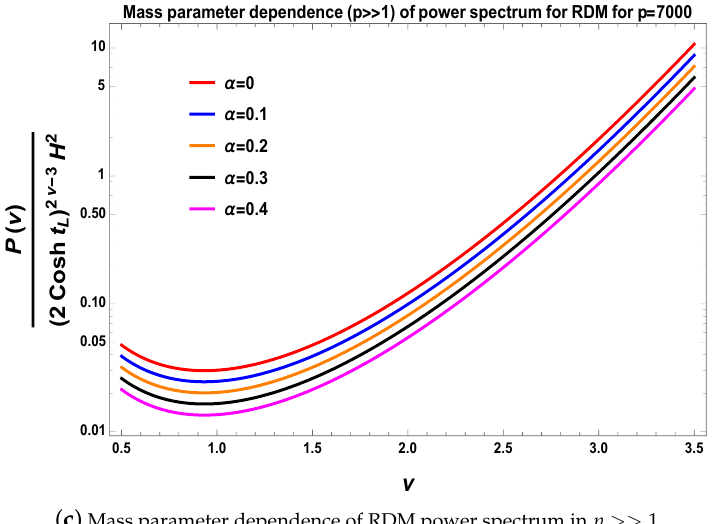
( a ) Large wave number dependence of RDM power spectrum for α = 0.